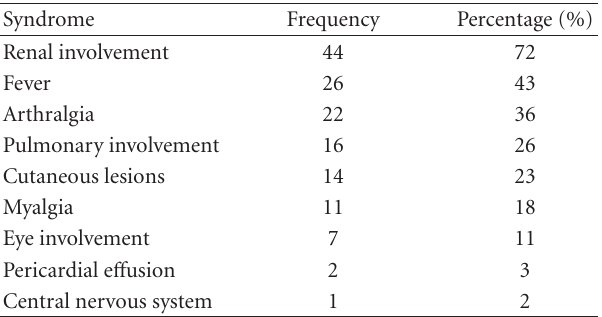
Table 2: Most frequent observed clinical symptoms in PTU- induced ANCA-associated vasculitis. In total, 61 well-described patients were